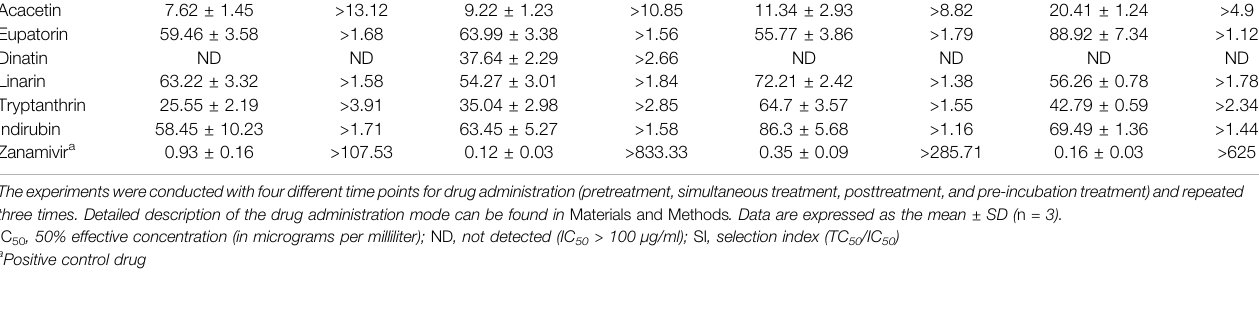
TABLE 3 | Cytopathic effect (CPE) reduction assay results of the six predicted compounds toward the wild-type strain A/Minfang/151/2000 (H3N2) Compound Pretreatment Simultaneous